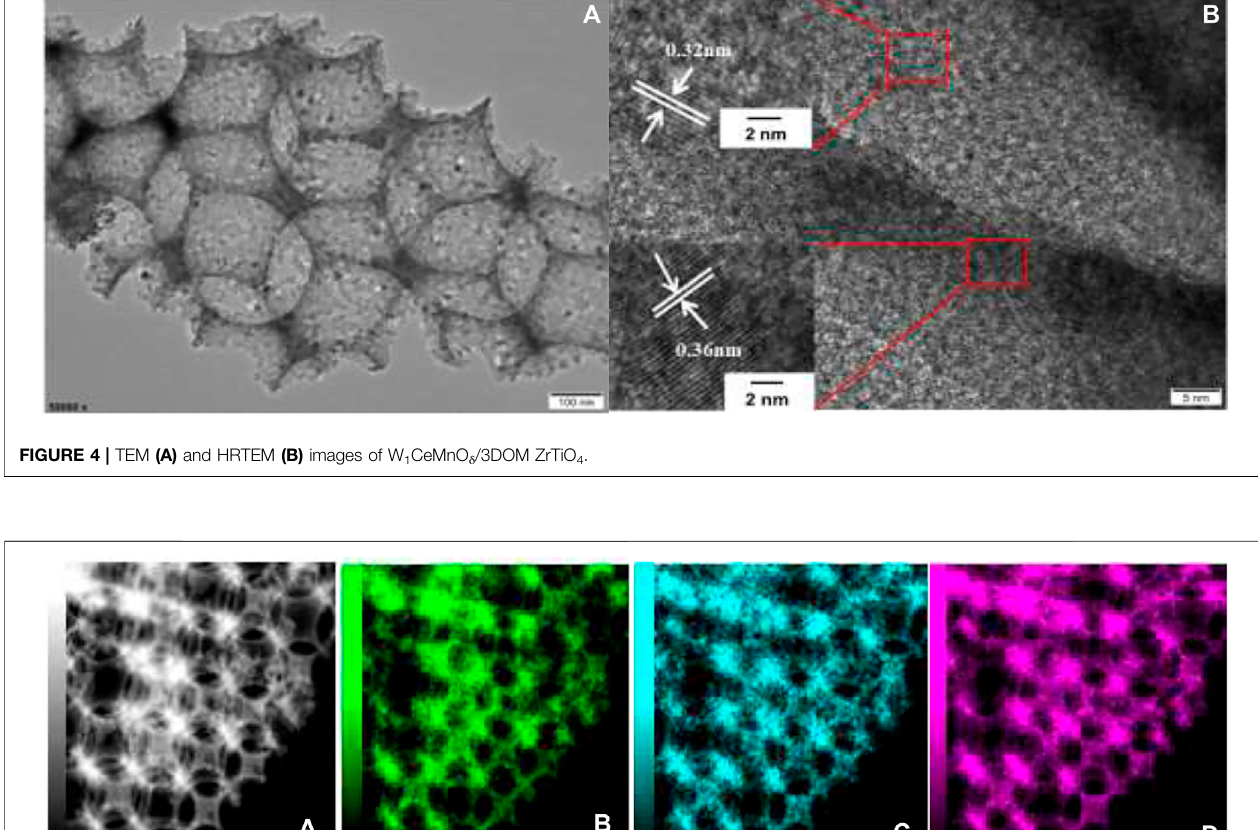
Frontiers in Chemistry |